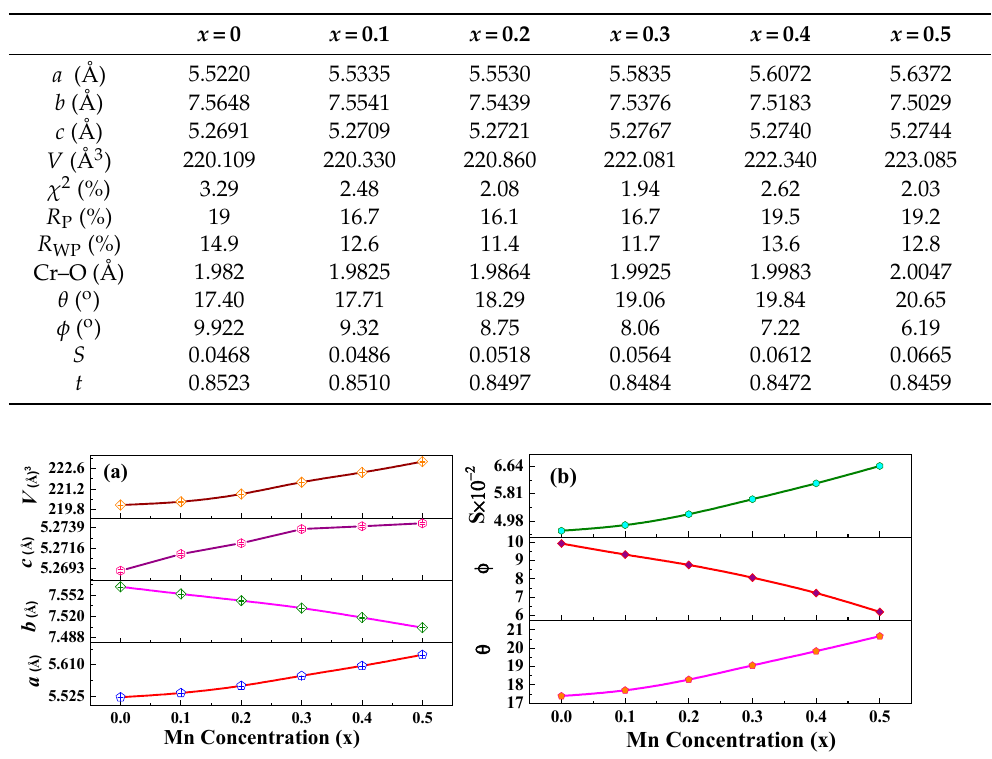
Table 1. Lattice parameters, unit cell volume ( V ), reliability factors, octahedral bond length, tilt angles, strain factor and Goldschmidt tolerance factor ( t ) of GECMO series.